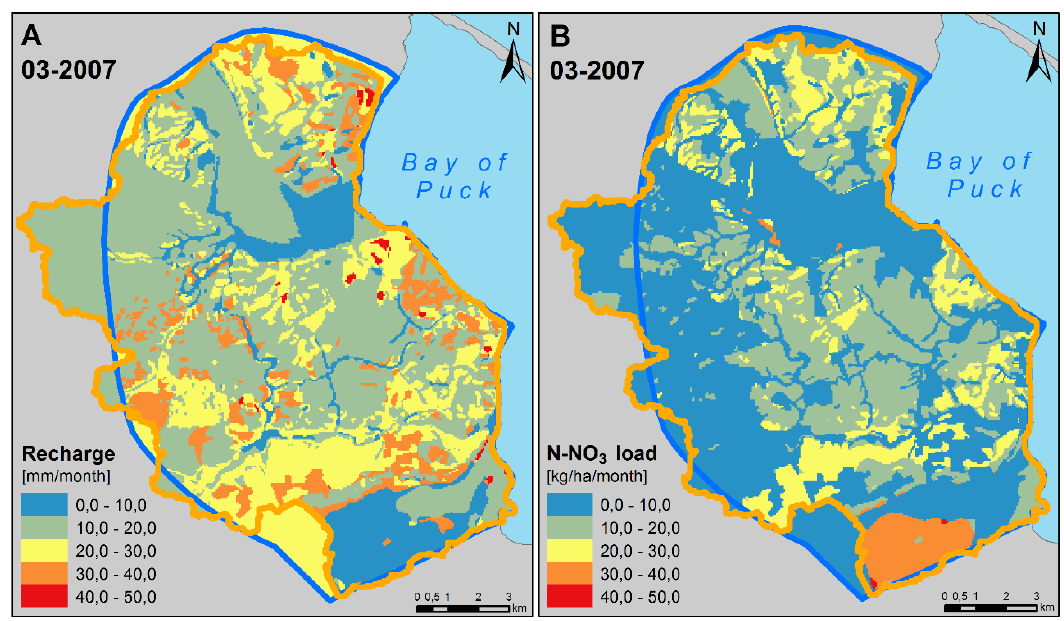
Figure 7. Spatial distribution of monthly recharge values ( A ) and the associated N-NO 3 loads ( B ) in the baseline scenario, March 2007.